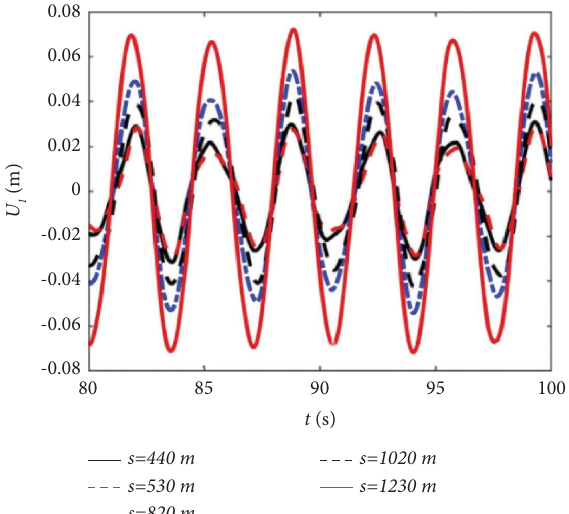
Figure 18: Time history of tangential motion.